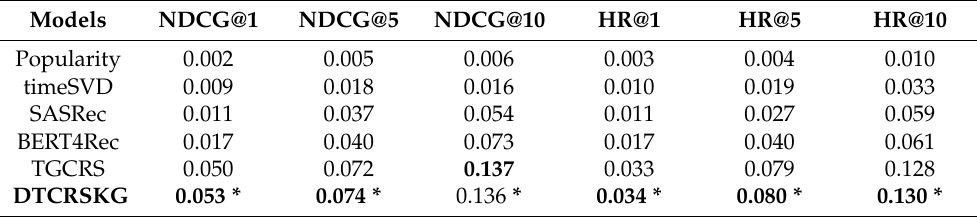
Table 3. Experimental results of performance comparison using the KdConvRec dataset.